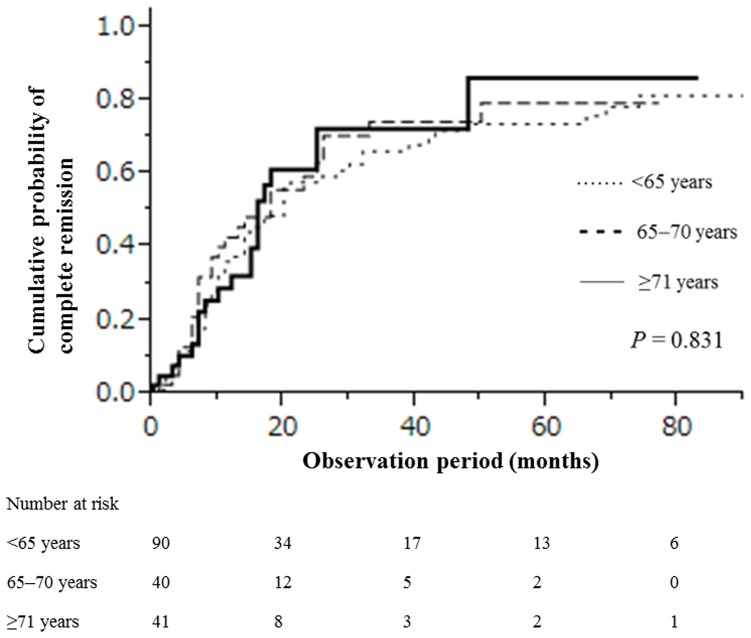
Cumulative probability of complete remission in 171 IMN patients stratified by age.